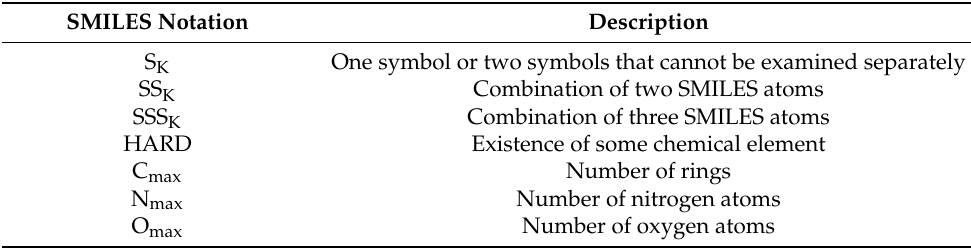
Number of oxygen